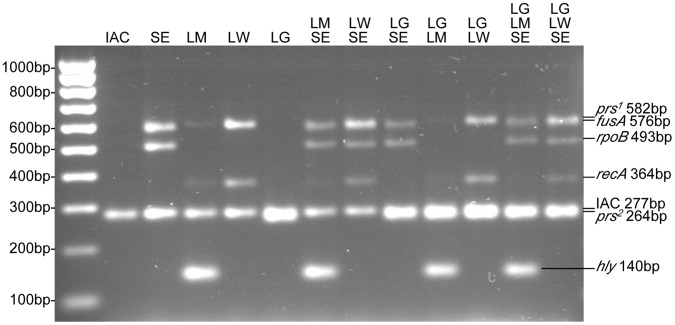
Multiplex Polymerase Chain Reaction amplification products shown following gel electrophoresis.Lanes 1 and 12 contain HyperLadder V (Bioline), with the remaining lanes containing products derived from 6 ng genomic DNA from as shown. Internal amplification control (IAC) template DNA was included in all reactions. Templates were amplified in isolation (apart from universal inclusion of the IAC) or in combination as described in the figure using a 15-primer multiplex PCR. Codes used are as follows: SE, Salmonella enterica MISE807439; LM, Listeria monocytogenes CMCC2993; LW, Listeria welshimeri CMCC3366; LG, Listeria grayi CMCC3362. Patterns for L. seeligeri, L. murrayi, L. ivanovii and L. innocua were identical to that of L. welshimeri, and all patterns shown were representative of all other strains tested of the same species. Size standards are descirbed on the left of the figure in base pairs (bp), while PCR products are described on the right of the figure with both their name and size in bp. 2 indicates the prs amplimer from Listeria grayi only, with 1 denoting the corresponding product from all other Listeria species. Electrophoresis was performed on a 1.7% agarose gel at 70 volts for 1.5 hrs with EtBr, with 4 ul of each product loaded.